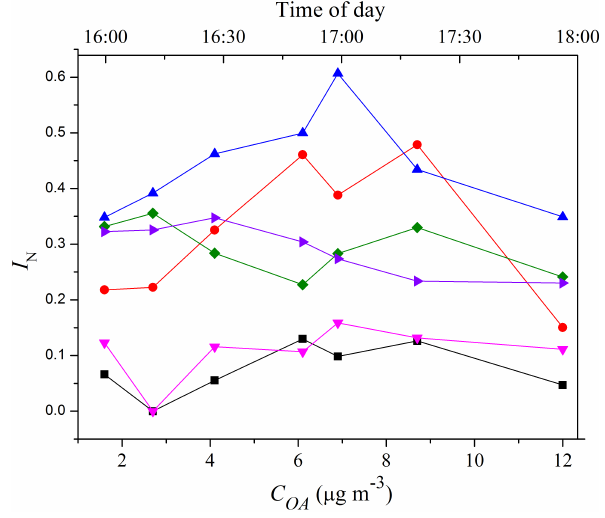
of 1.30. Each mass 576